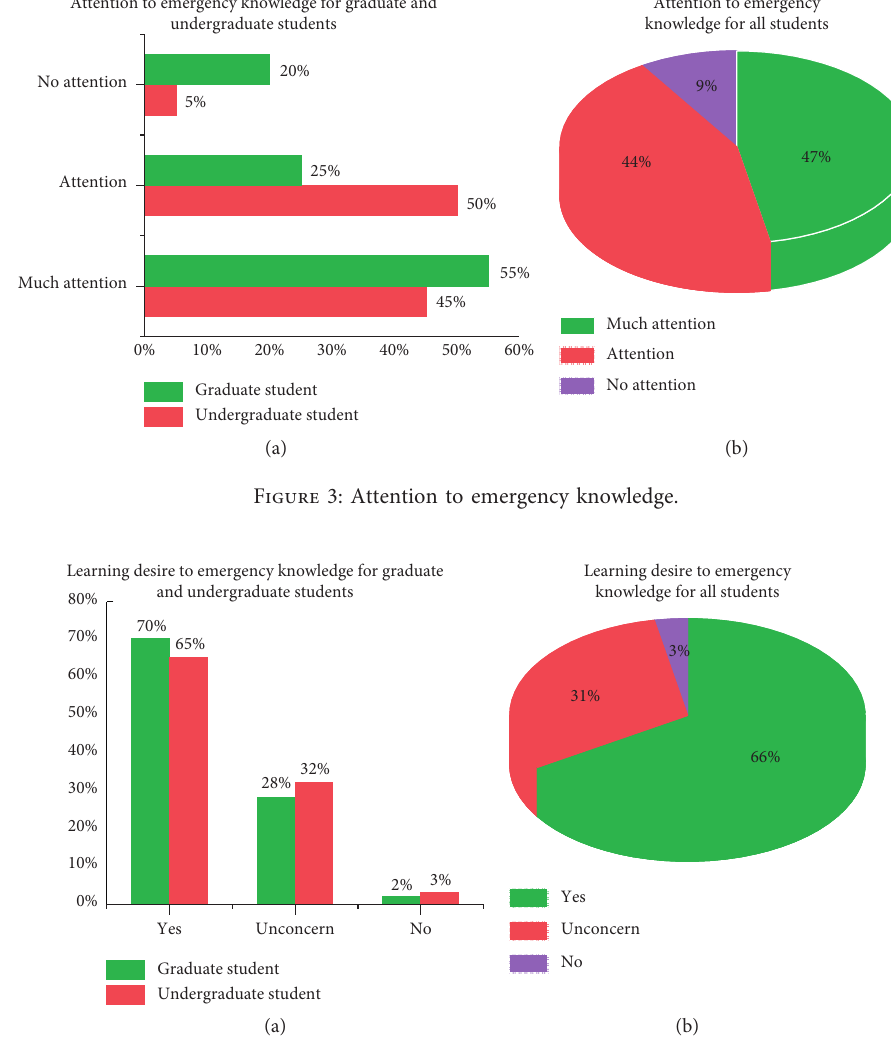
Figure 4: Learning desire to emergency